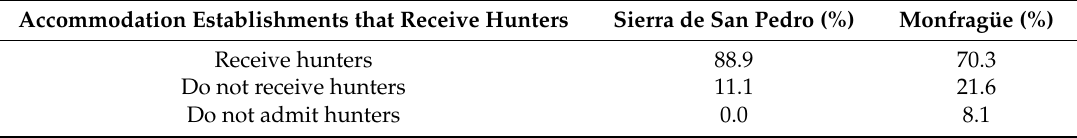
Table 7. Accommodation establishments that receive hunters.